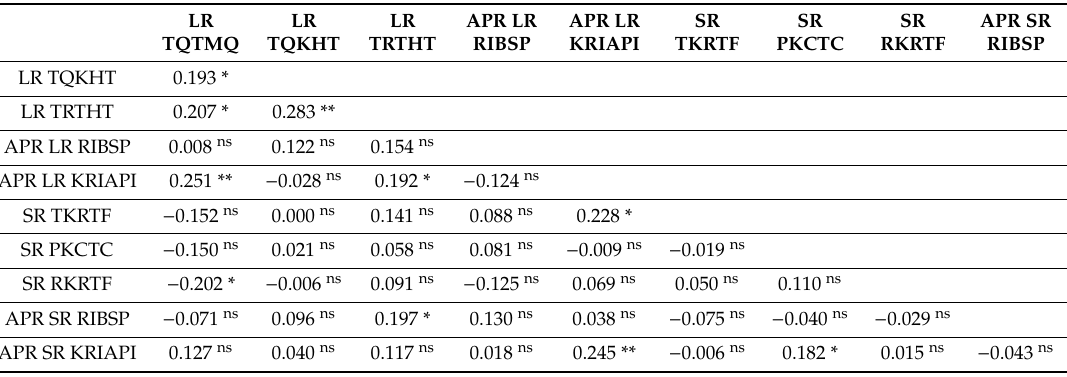
Table 5. Correlations among race-specific seedling resistance and adult plant resistance (APR) to leaf rust (LR) and stem rust (SR) in the Pamyati Azieva × Paragon mapping population.